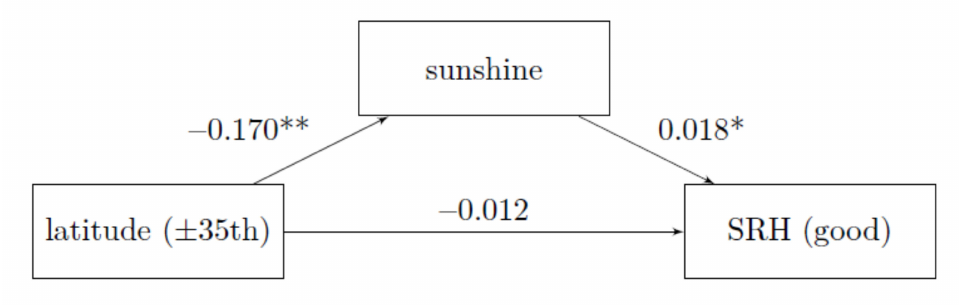
Figure 3. Mediation without control variables, ISSP 2011; average marginal effects; own calculation and representation; ** p < 0.01, * p < 0.05, proportion mediated: 14.14 %; N = 18,006.